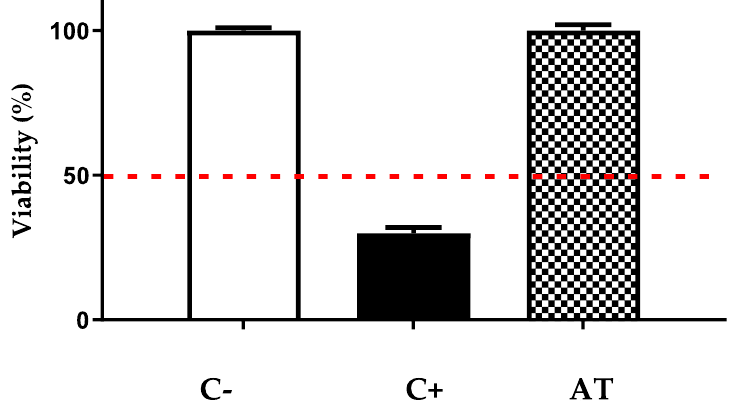
Figure 2. Test for skin irritant potential of Arnica tincture. The bars represent the means ± SD of the percentage of cell viability after 42 min of exposure and 42 h of incubation. C-: negative control; C+: positive control; AT: Arnica tincture.